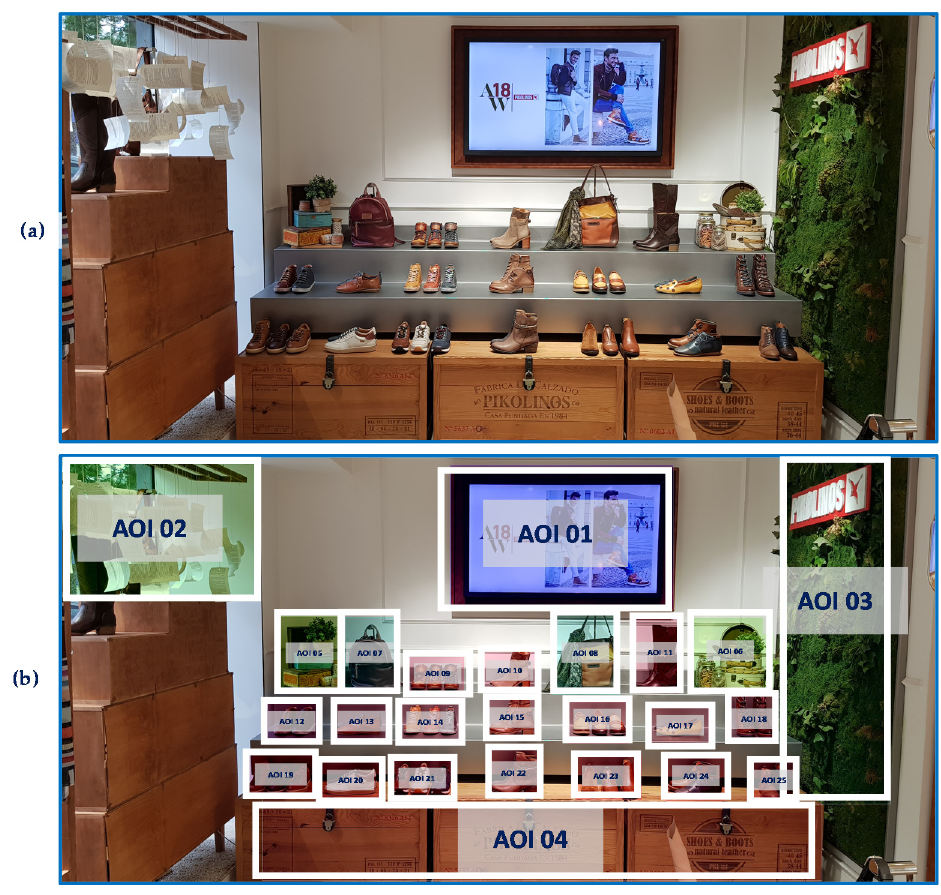
Figure 2. Footwear store area. Original image ( a ) and Areas of Interest ( b ). Source: Prepared by the authors. Table 2. Footwear store area. Areas of Interest and description.